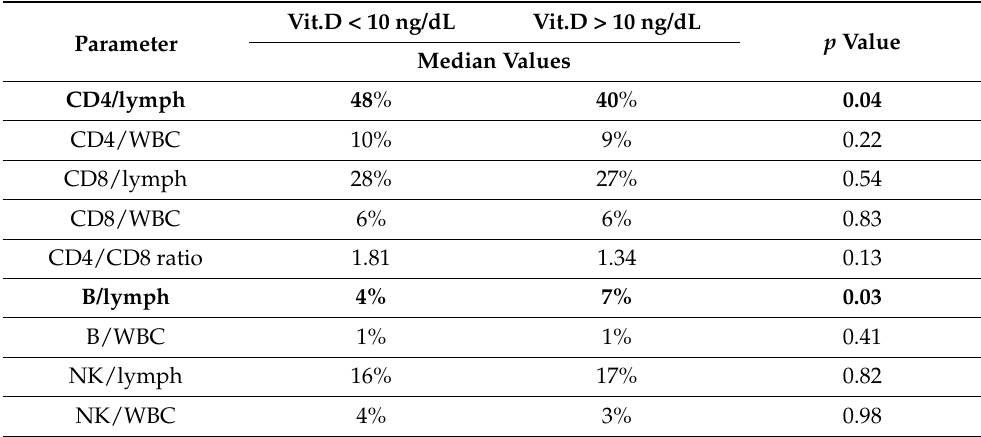
Vit.D: vitamin D; WBC: white blood cells; lymph: lymphocytes; NK: natural killer